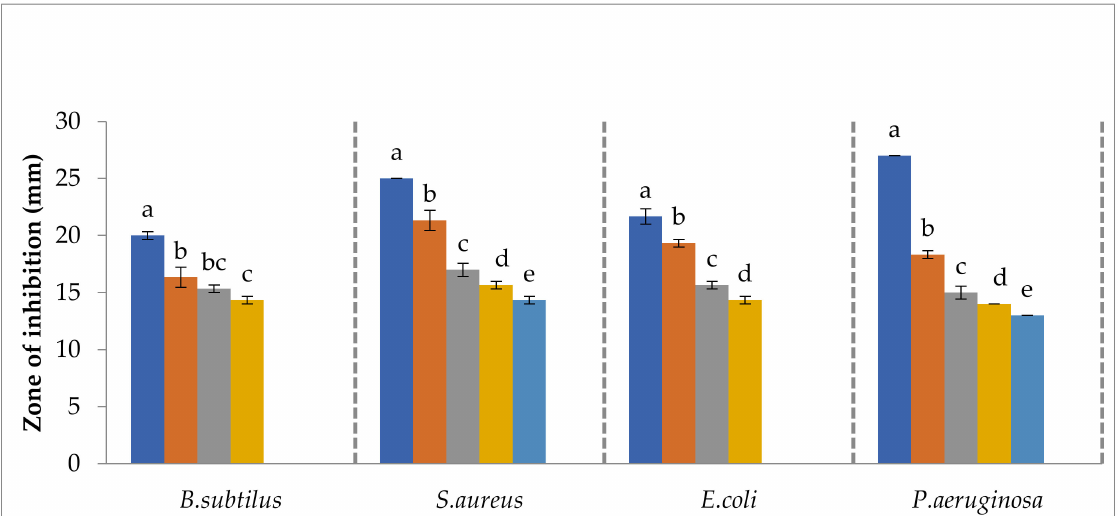
Figure 10. Antibacterial activity of nanoparticles (Nm) synthesized from methanolic extract of aerial parts of Aerva javanica against pathogenic strains Bacillus subtilis , Staphylococcus aureus , Escherichia coli , and Pseudomonas aeruginosa at different concentrations as shown in Figure 8. Different letters are indicating significant differences ( p < 0.05) among treatments.